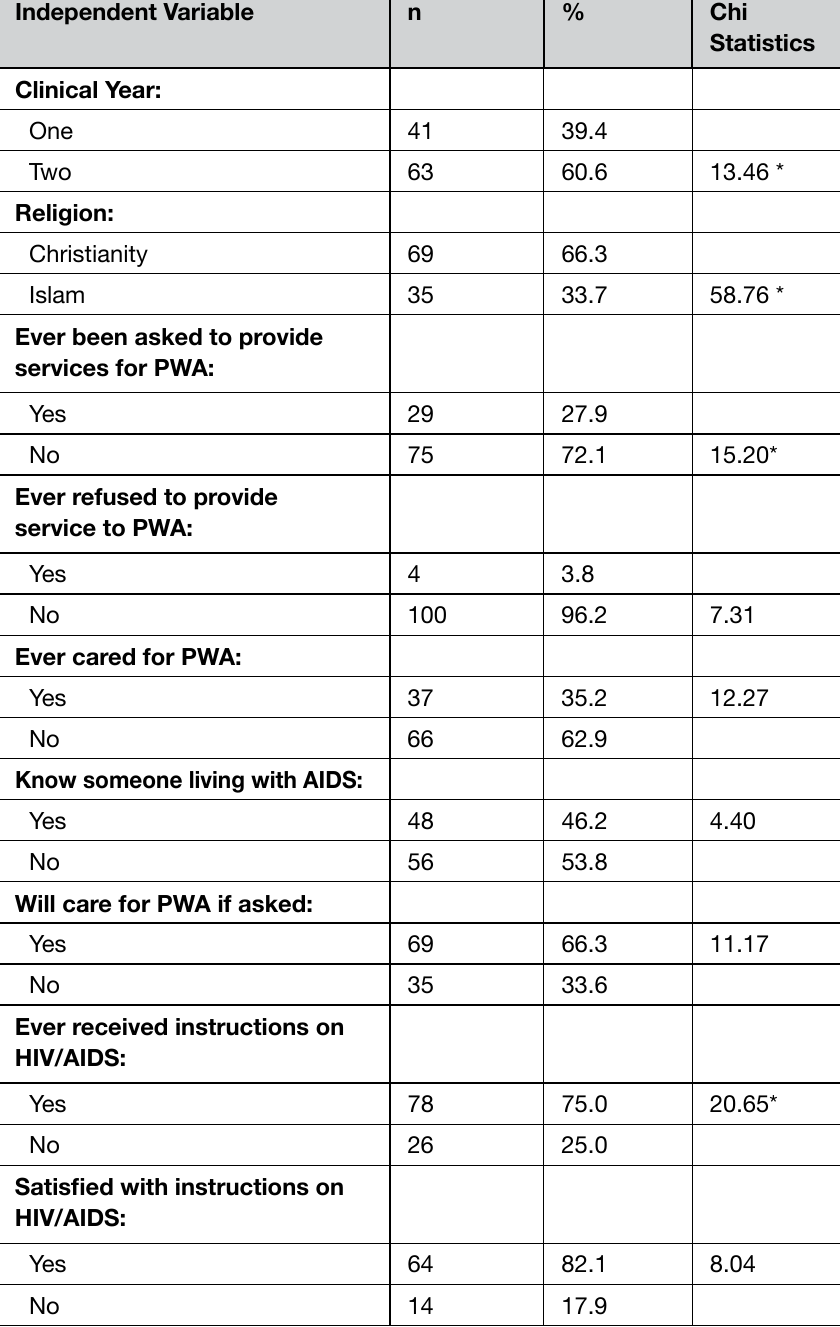
Table 1: Students’ demographic characteristics and previous experience and encounters with persons living with AiDS